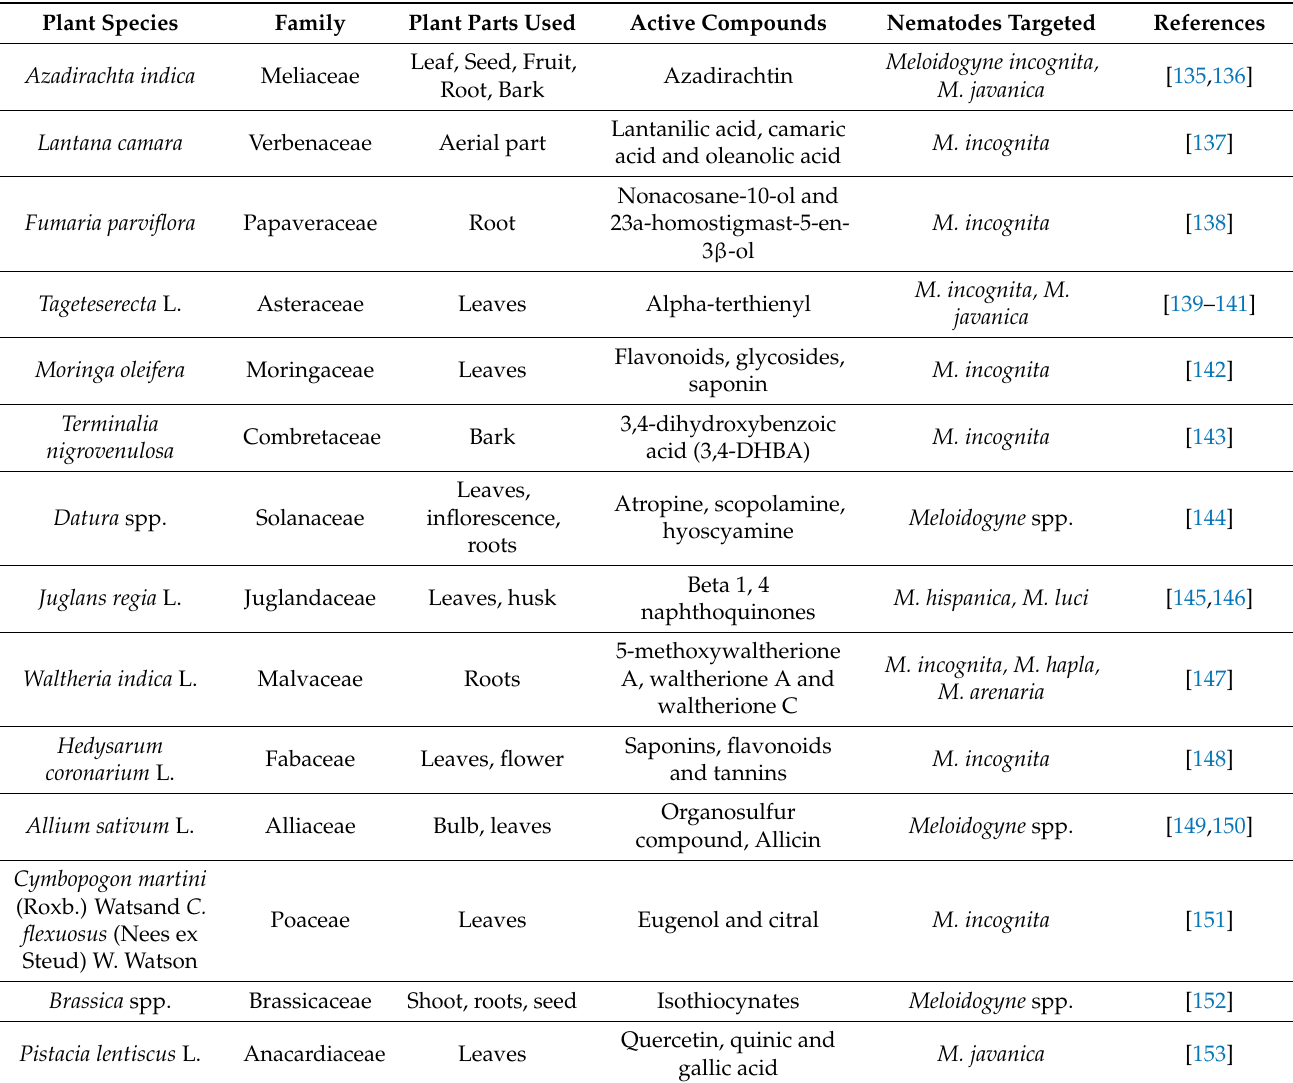
Table 3. Plant extracts for biocontrol of root-knot